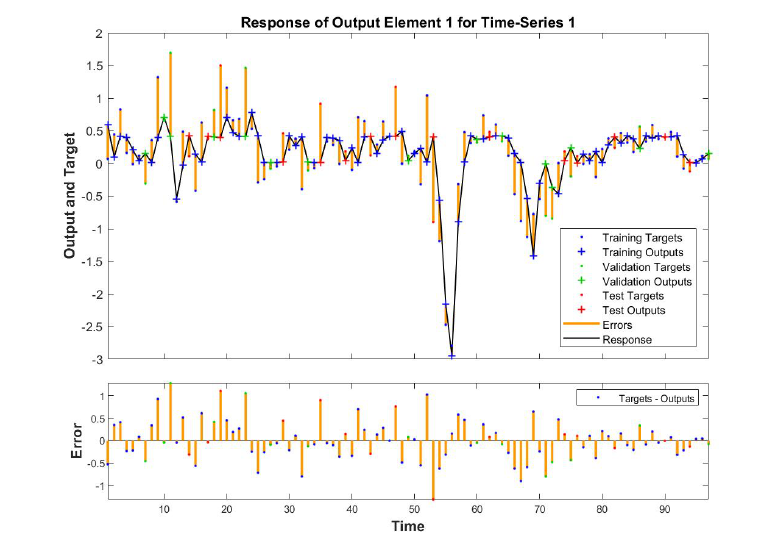
Figure 10. Italian GDP growth rate for the period from 1995:Q1 to 2019:Q2 forecast with NAR techniques (top box) and the estimation errors (below box) - (Data source for GDP growth rate: OECD.Stat, 2019, ‘own